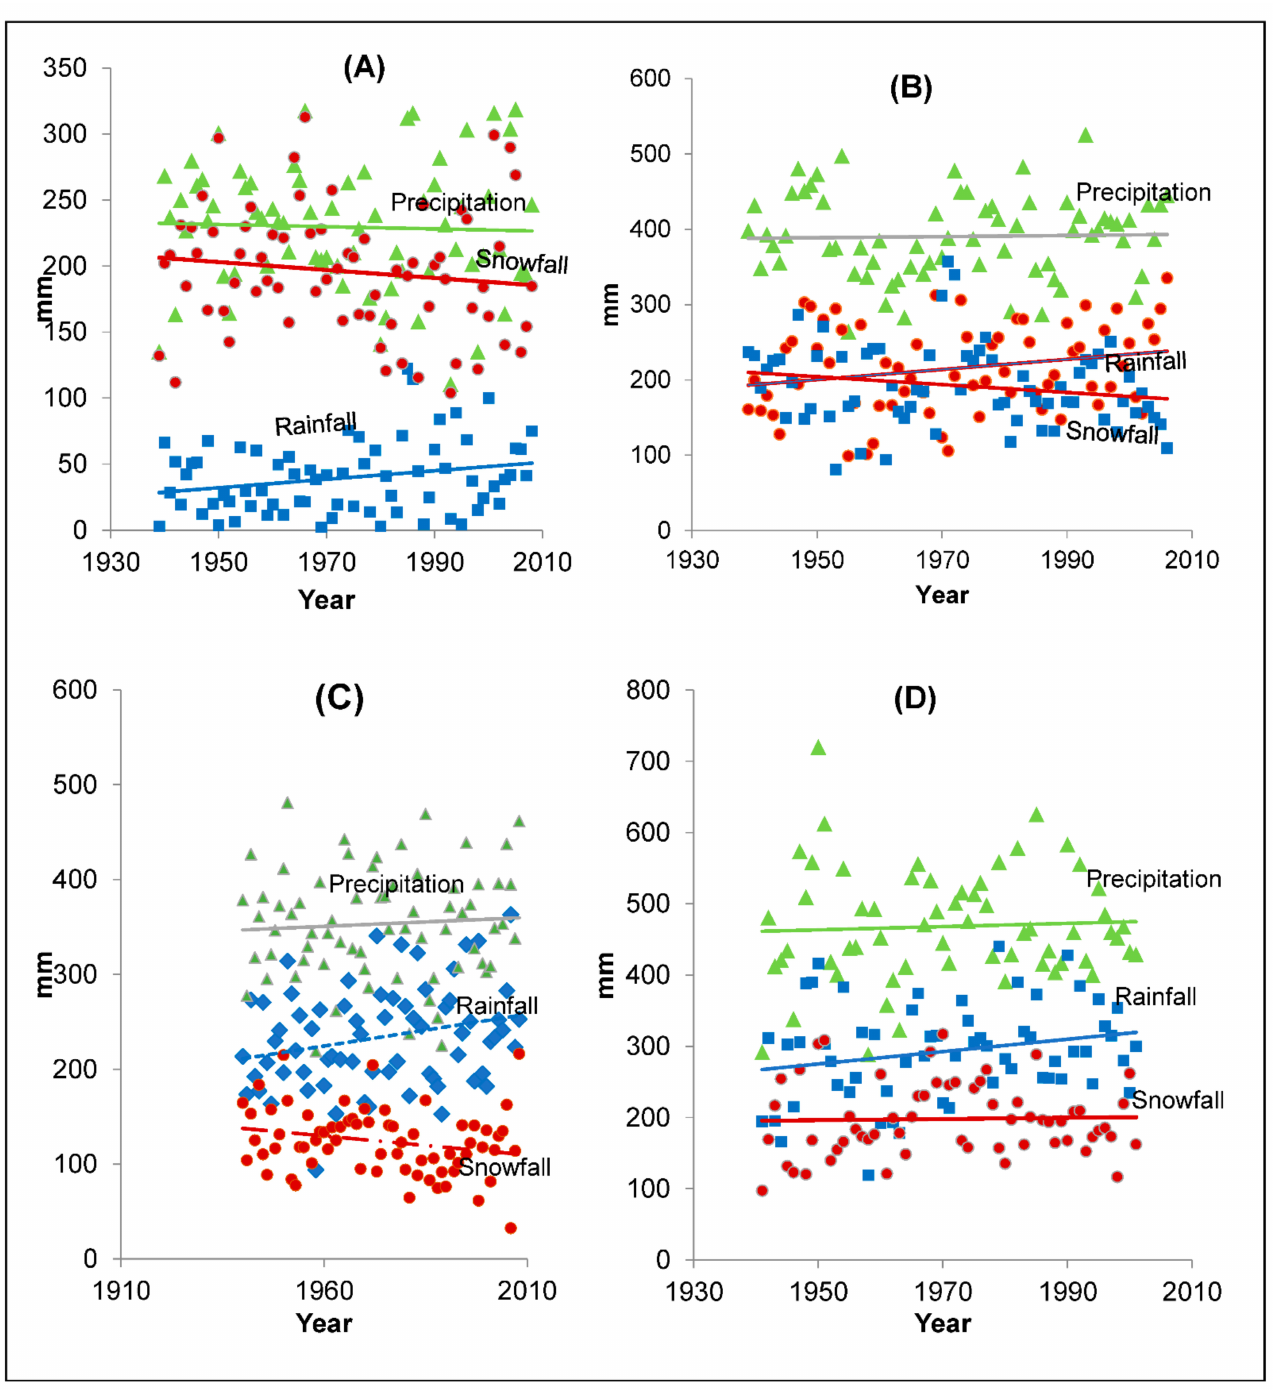
Figure 2. Trends of total precipitation, rainfall, and snowfall during winter at Sioux Lookout ( A ), Ottawa ( B ), Toronto ( C ), and London ( D ),